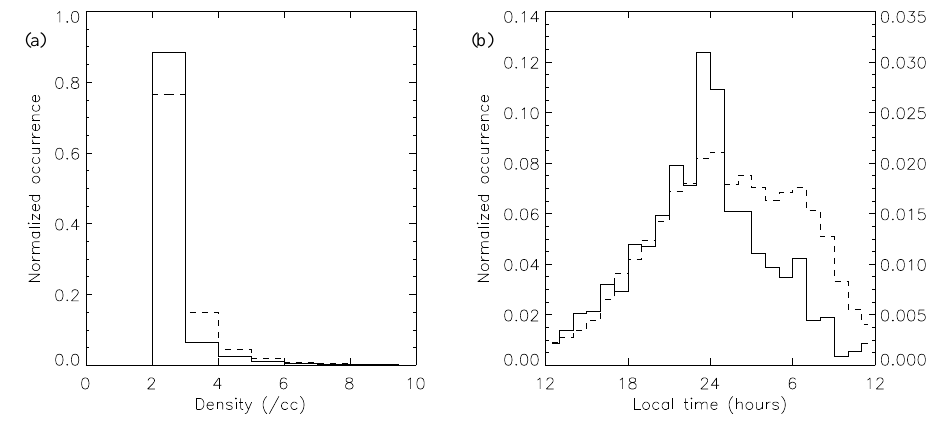
Fig. 1. Distributions of dense plasma measurements ( > 2cm − 3 ) by the MPA instrument on board the Los Alamos satellites at geosynchronous orbit, for the period 1990–2002. (a) Normalized density distributions of zero epoch (initial) and total dense plasma measurements. The solid line corresponds to the density distribution of the dense plasma measurements from zero epoch (normalized to the total number of zero epoch dense plasma events) while the dashed line corresponds to the density distribution of all dense plasma measurements recorded at geosynchronous orbit (normalized to the total number of dense measurements). See text for details. (b) The solid line is the local time distribution of the initial dense plasma events, normalized to the total number of events. The dashed line is the local time distribution of all dense plasma measurements. For this latter distribution, the total number of dense plasma measurements in each local time bin is normalized to the total number of measurements (regardless of density) recorded in that local time area during the period